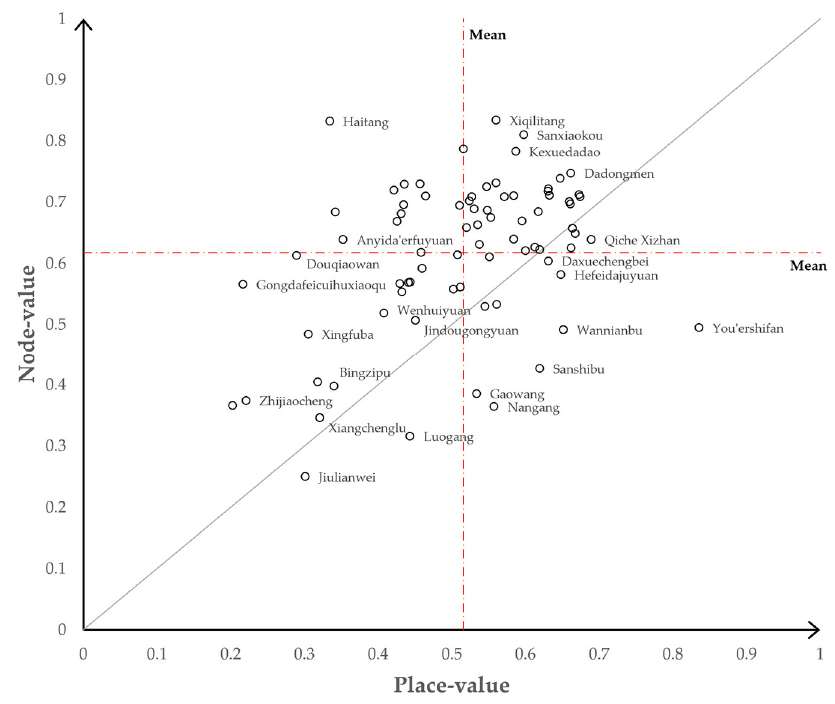
Figure 4. The 77 existing TODs in the node–place model.